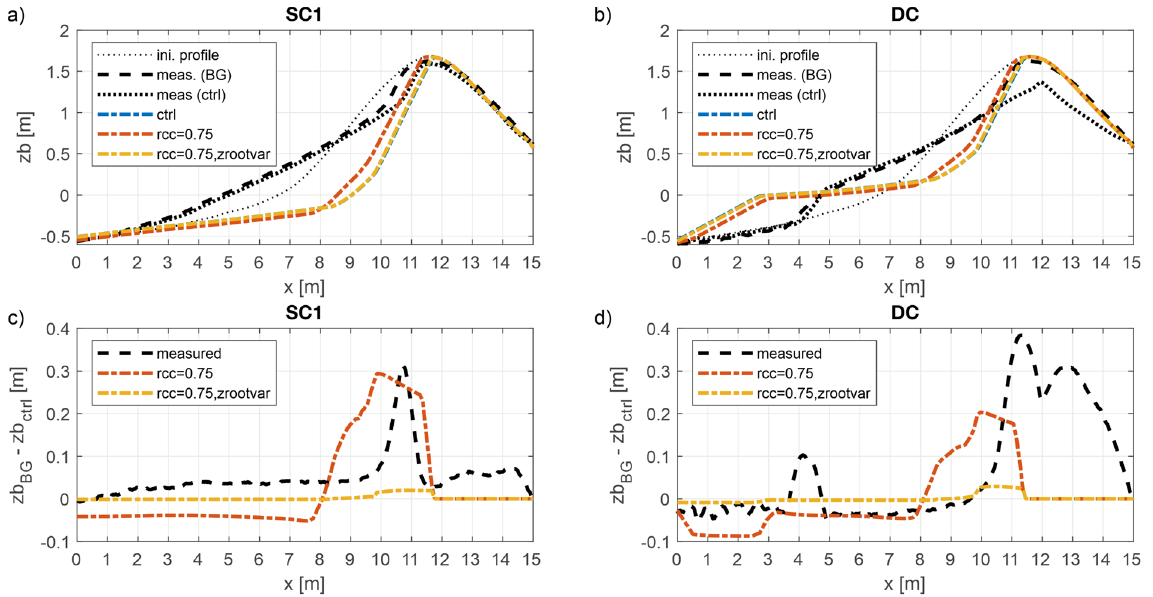
Figure 5. Modeling collision conditions with belowground biomass: Comparison of initial (thin dotted), final measured control (thick dotted) and final measured BGB (dashed) dune profiles with simulation results (dash-dotted), including the control simulation (blue) and the application of the root model with constant (orange) or varying rooting depth (yellow) for a shallow collision ( a ) and a deep collision ( b ). Profile differences (belowground to control) are shown for the measurements (dashed) and the simulations (dash-dotted) for shallow ( c ) and deep collisions ( d ). Note : Overlay of the blue and yellows lines in ( a , b ).